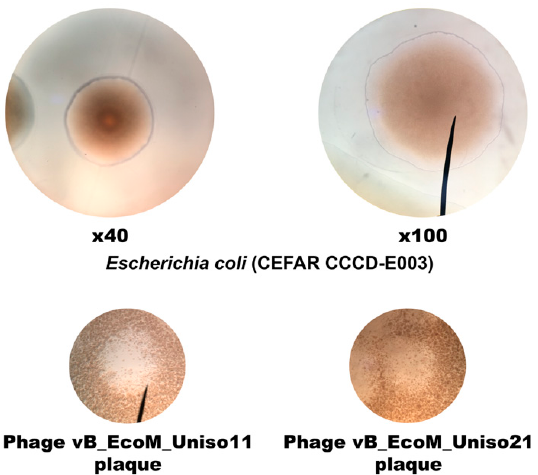
Figure 6. Morphological characteristics of E. coli CCCD-E003 host colonies on solid TSA, allowing for the observation of cell swimming motility characteristics, and of phages vB_EcoM_Uniso11 and vB_EcoM_Uniso21 plaques of lysis on a bacterial host lawn. E. coli cells display two flagella-driven motility types, swimming (movement of indi- vidual cells in either liquid medium or semisolid soft agar) and swarming (collective cel- lular movement on semisolid agar) [93]. As can be observed in Figure 6, the E. coli cells exhibited swimming motility. The phage plaques on the bacterial host lawn were tiny and displayed diameters ranging from ≈ 0.5 to ≈ 1 mm (Figure 7). 3.5. Phage Plaque Isolation Phages vB_EcoM_Uniso11 and vB_EcoM_Uniso21, isolated from sewage water of the Veterinary Hospital at UNISO (Sorocaba/SP, Brazil), formed dimensionally different and clear plaques on the E. coli CCCD-E003 lawns, with diameters ranging from ≈ 0.5 to ≈ 1 mm (Figure 7). No secondary halo could be observed in the frontier of the lysis plaques of phages vB_EcoM_Uniso11 (Figure 7a) and vB_EcoM_Uniso21 (Figure 7b), indicative of the absence of production of phage depolymerases [94,95] by these phages (zoomed out plaques). High titer suspensions (10 11 PFU/mL) were obtained for the two phages.